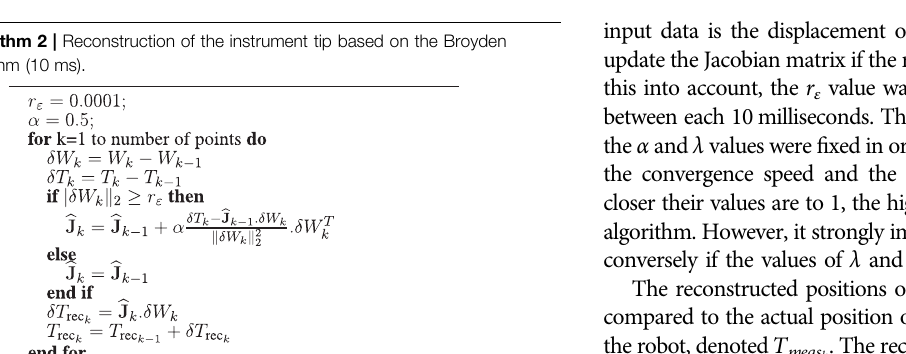
FIGURE7| Measuredpositionoftherobotwrist(green)andtheinstrumenttip(red)duringadisplacement.Evolutionofthereconstructionerror ε T two experiments with the ALAM (A,B) and Broyden (C,D) estimators.